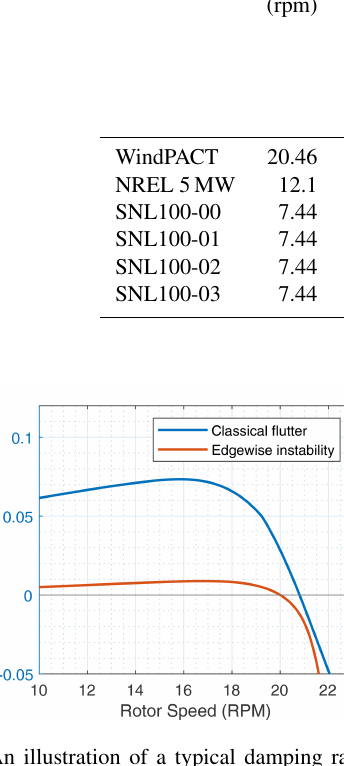
Figure 4. Illustration of first edgewise unstable mode for the SNL100-03 blade.